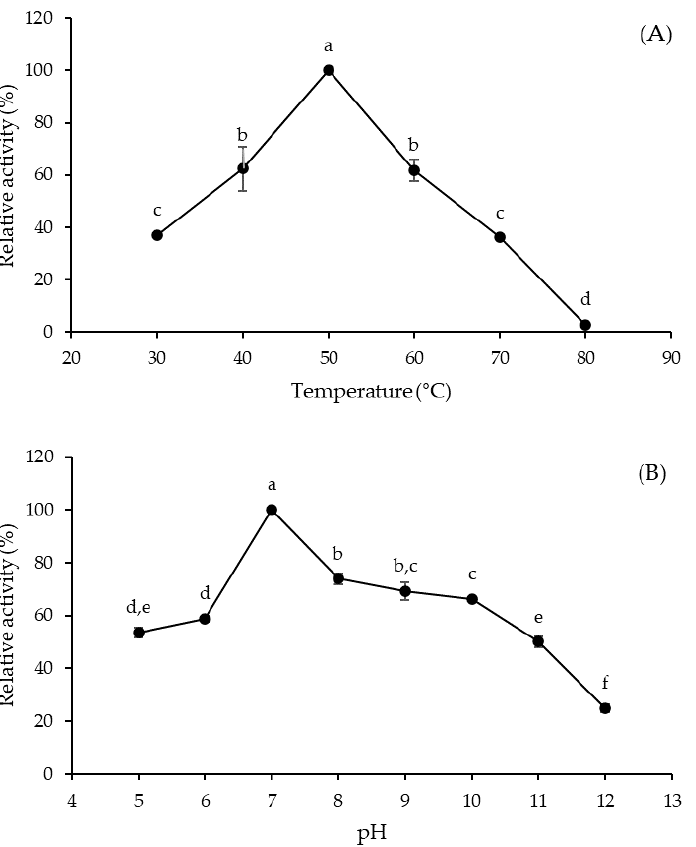
Figure 2. Effects of temperature ( A ) and pH ( B ) on the activity of Aspergillus tamarii URM4634 protease produced by sequential fermentation using wheat bran as a substrate. Different letters (a–f) indicate statistically significant differences ( p < 0.05).